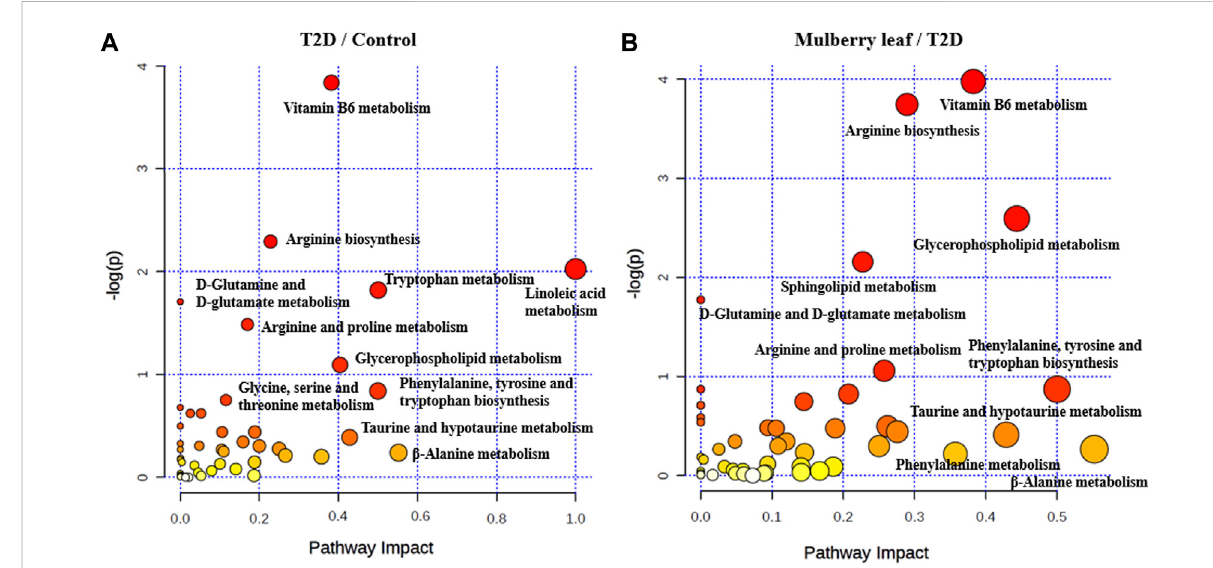
FIGURE 7 Bubble diagram of the differential metabolite pathway analysis in the serum of rats (A) T2D vs. control (B) ML vs.